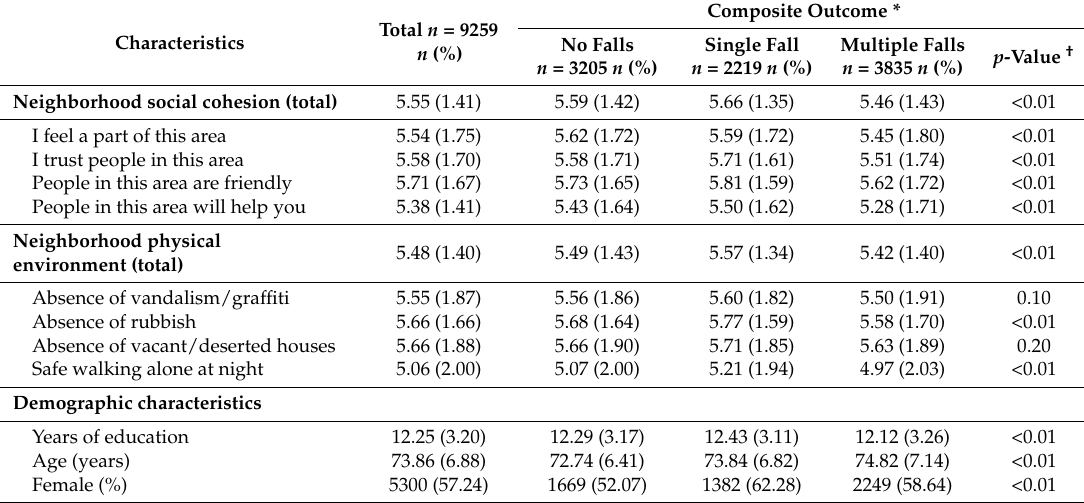
Table 1. Baseline characteristics of the study population, n =